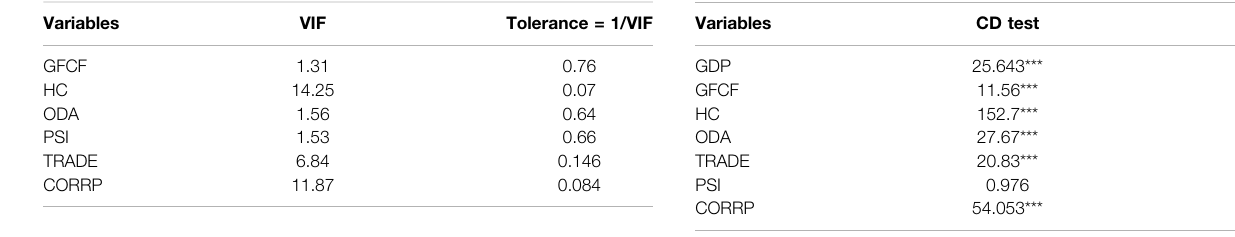
TABLE 4 | Test results for multicollinearity. TABLE 5 | Results for cross-sectional dependence